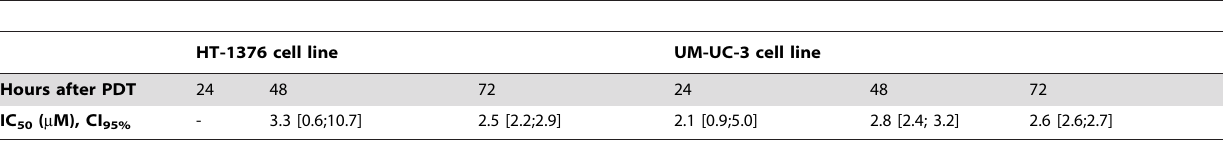
Table 1. Values for photocytotoxic concentration (IC 50 , m M) of photoactivated PcGal 16 on human bladder cancer cell lines, HT- 1376 and UM-UC-3.